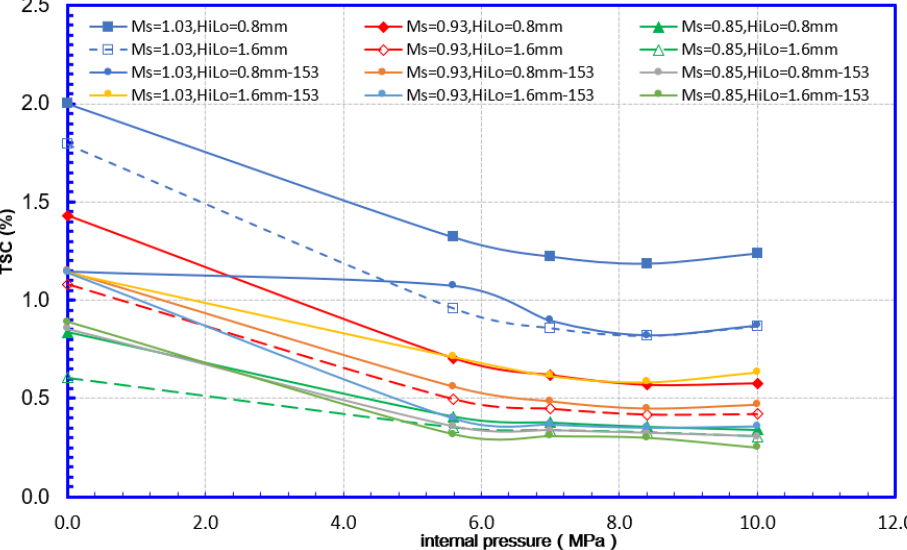
Figure 16. Mismatch and internal pressure effects on TSC 12.8 mm — 12.8 mm WT and 12.8 mm — 15.3 mm